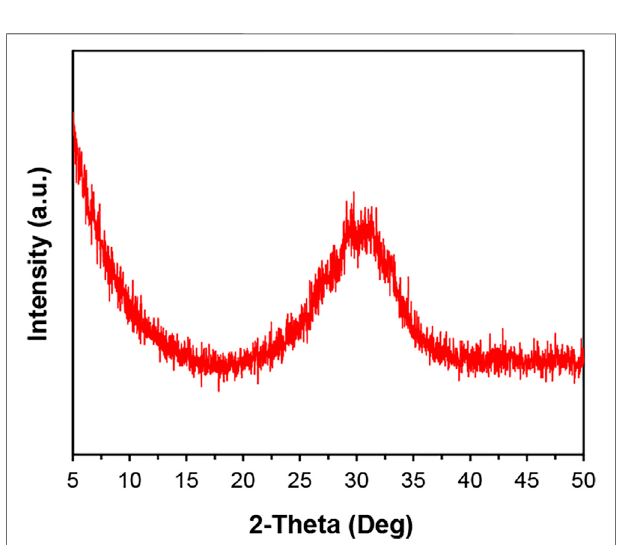
FIGURE 2 | Analysis of XRD pro fi le of the studied slag